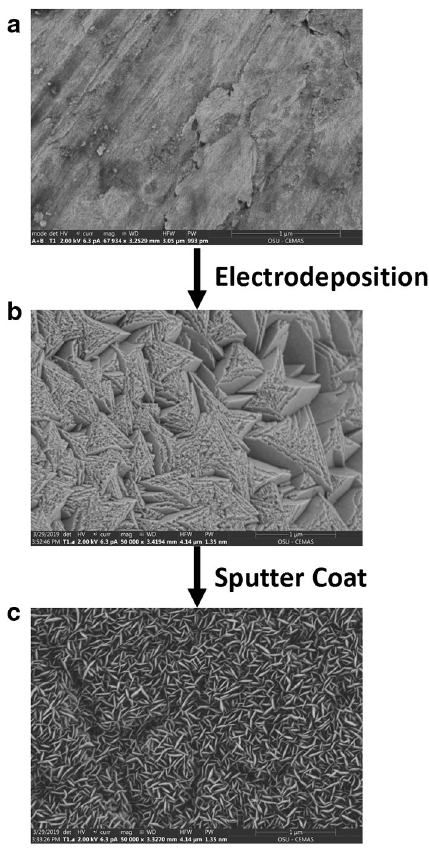
Figure 1. SEM of the cathode surface. ( a ) Bare copper mesh substrate, ( b ) electrodeposited copper oxide on copper mesh, and ( c ) Ni nanolayer as sputter-deposited on copper oxide-copper substrate. Scale bar = 1